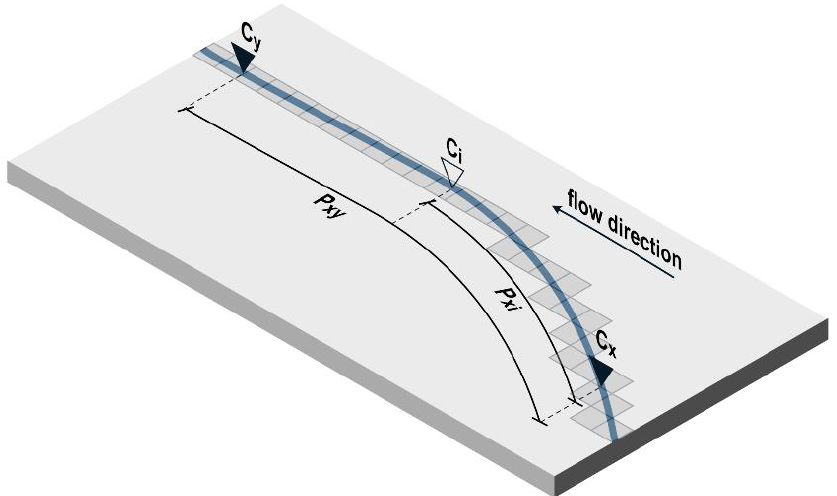
Figure 3. Scheme of linear interpolation developed in this